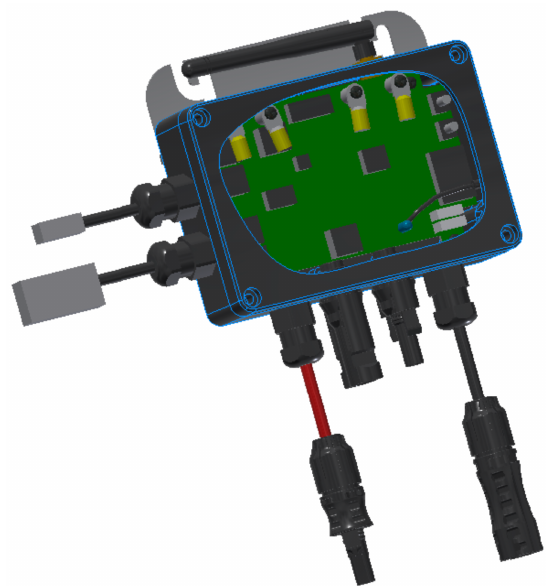
Figure 2. 3D model of SmartPV